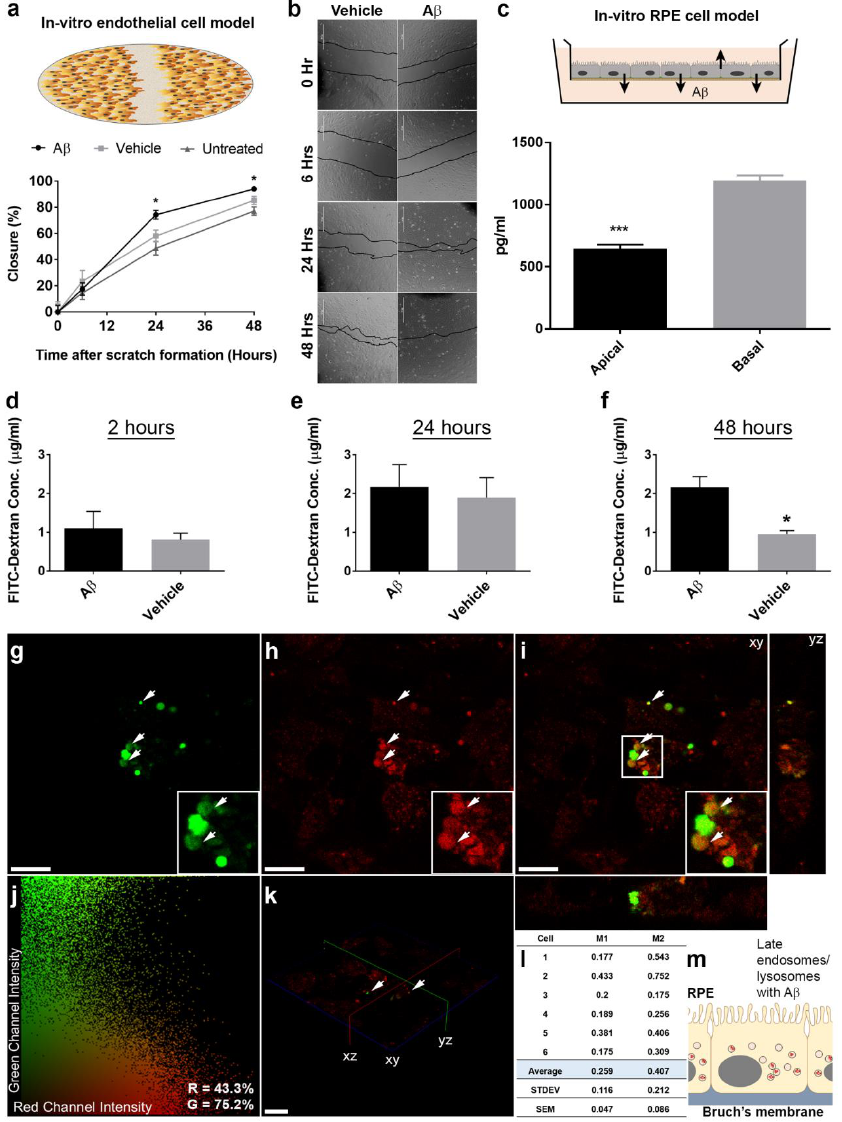
Figure 5. Human oligomeric Aβ 1-42 directly targets choroidal endothelial and RPE cells. ( a ) The consequences of Aβ exposure on choroidal endothelial cells were studied using a scratch assay. ( b ) Representative bright filed images showing closure of the scratch between 0, 6, 24 and 48 h after treatment with either 1 μM of human oligomeric Aβ 1-42 or vehicle. Exposure to Aβ resulted in a significantly rapid closure of the scratch at 24 and 48 h compared to vehicle or untreated controls ( n = 4). One-way ANOVA with Tukey’s multiple comparisons test, where * denotes a significance of p ˂ 0.05. ( c ) As the RPE is a major source of retinal Aβ, we next quantified total soluble Aβ 1-x levels in an in vitro model. Significantly higher amounts of Aβ was preferentially secreted via the basolateral RPE surface compared to Aβ levels secreted apically ( n = 3 from 3 independent experiments). Unpaired Student’s t -test, where *** denotes a significance of p ˂ 0.001. To deter- mine whether exposure to elevated Aβ impaired integrity of the RPE barrier, we quantified the passage of a FITC-dextran